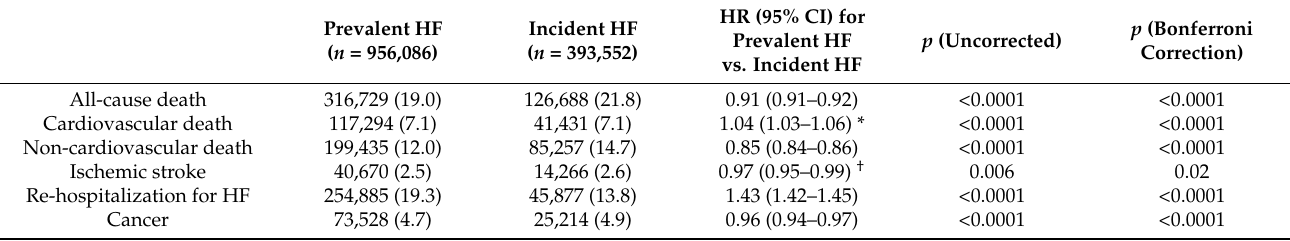
Table 4. Clinical outcomes during the whole follow-up in the unmatched cohort of patients with AF and prevalent or incident HF with follow-up starting at the time of last event between AF or